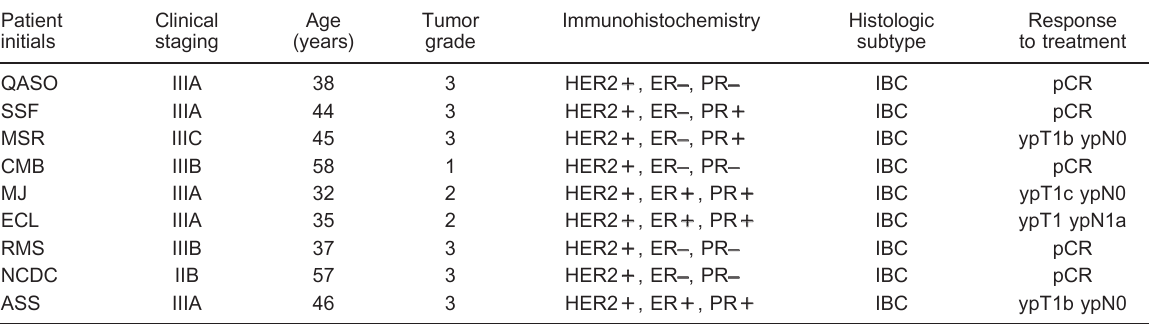
Table 1. TraQme cohort: demographic characteristics and response assessment to neoadjuvant metronomic chemotherapy.